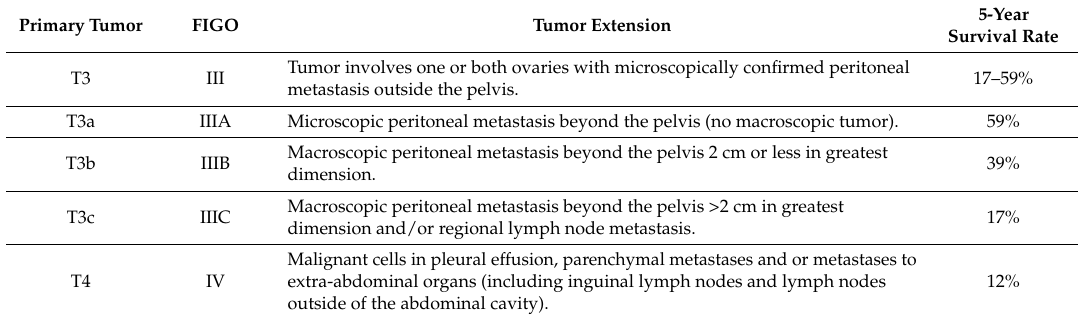
5-Year Survival Rate 17–59% 39% 17%